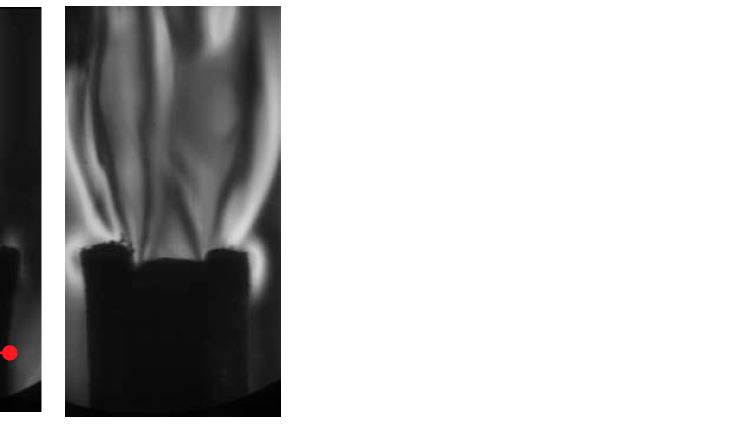
Figure 21. HTPB/AP/HTPB sandwiches at 0.5 MPa ( left ) and 1.5 MPa ( right ). Reprinted with permission from Ref. [42] (2022).